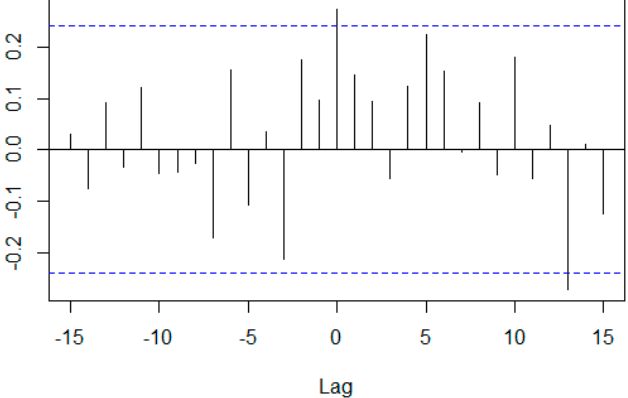
Figure 11. Cross-correlation coefficient between the average CAR of the whole sample group and the average CAR of the camera group for Evaluation period: Jan 2010–Dec 2011, Event period: Jan 2013–Jul 2018.